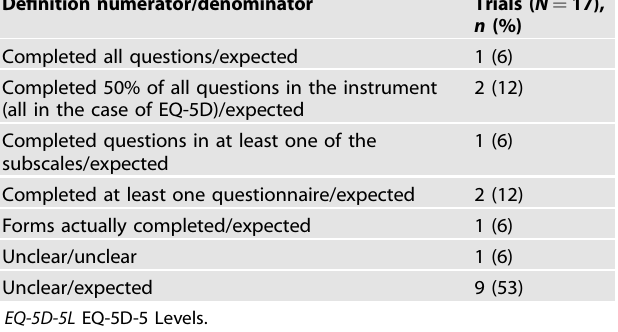
Table 4. De fi nition of Compliance.